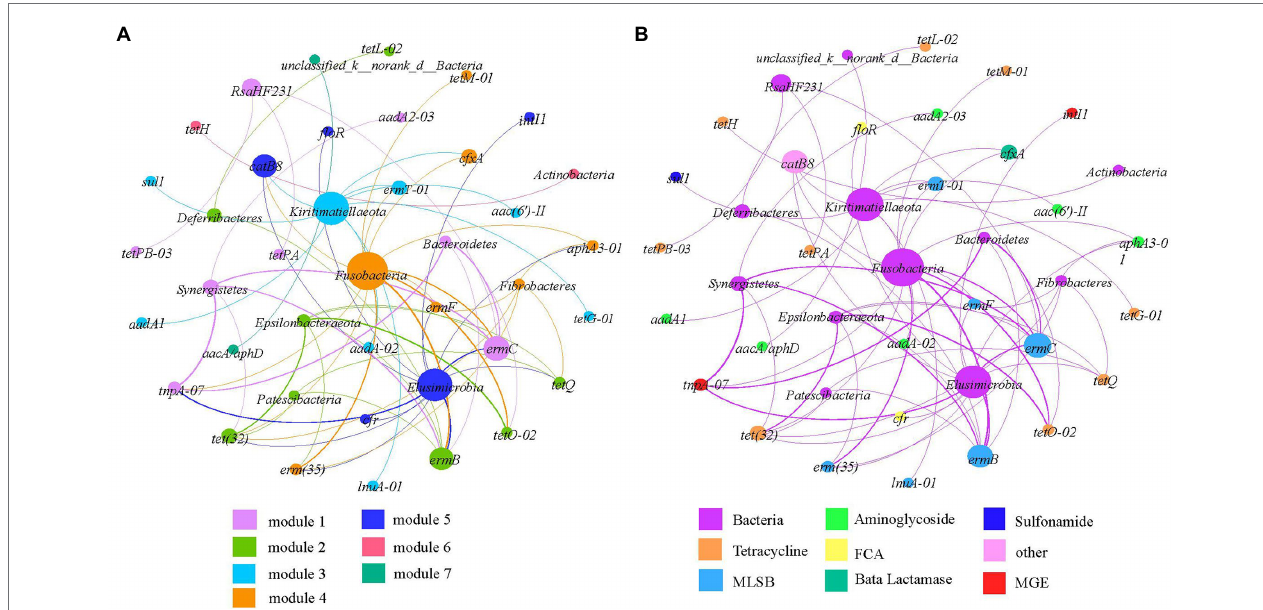
FIGURE 5 | Network analysis revealing co-occurrence patterns among ARGs and bacterial taxa at the phylum level based on modularity taxa (A) and ARGs taxa (B) . The nodes coded with different colors represent different ARGs/MGEs and bacteria, and the edges correspond to strong and significant correlations between nodes. The size of each node is proportional to the number of significant correlations between nodes. The thickness of the edges is proportional to the correlation